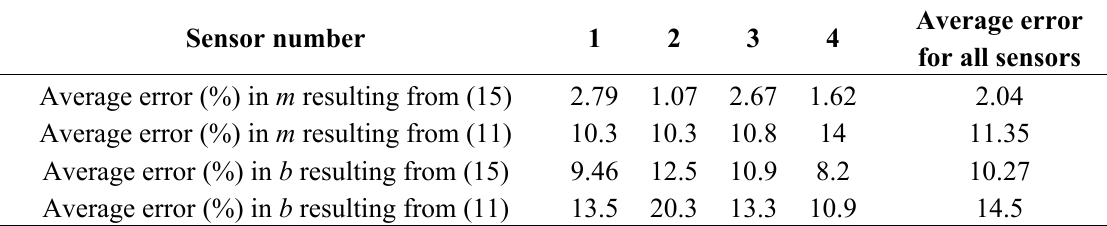
Table 1. Comparison table of the average errors resulting from the estimation of m, b by means of a linear Equation (11) and a nonlinear Equation (15) under input voltages within the range (0.4 V, 0.9